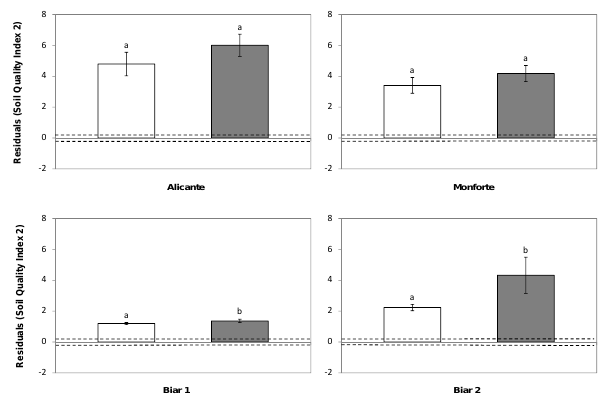
Fig. 2. Soil quality index 1 for each of the study sites. Dash lines limit 95% confidence interval of calibration (–0.21, + 0.21). Con- trols are indicated with white colour bars and irrigated with wastew- aters with dark grey colour. Different letters indicate significant dif- ferences between means at ( P< 0 . 05) after T-Student test. Error bars denote standard deviation.